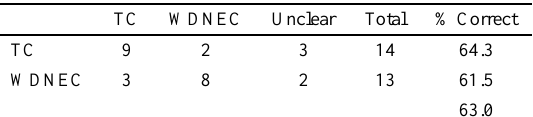
Specimen classification results of TC and WDNEC and selected features with F -values Specimen